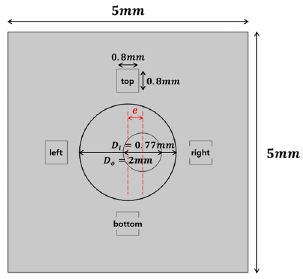
Figure 1. Schematic of the modeled channel.